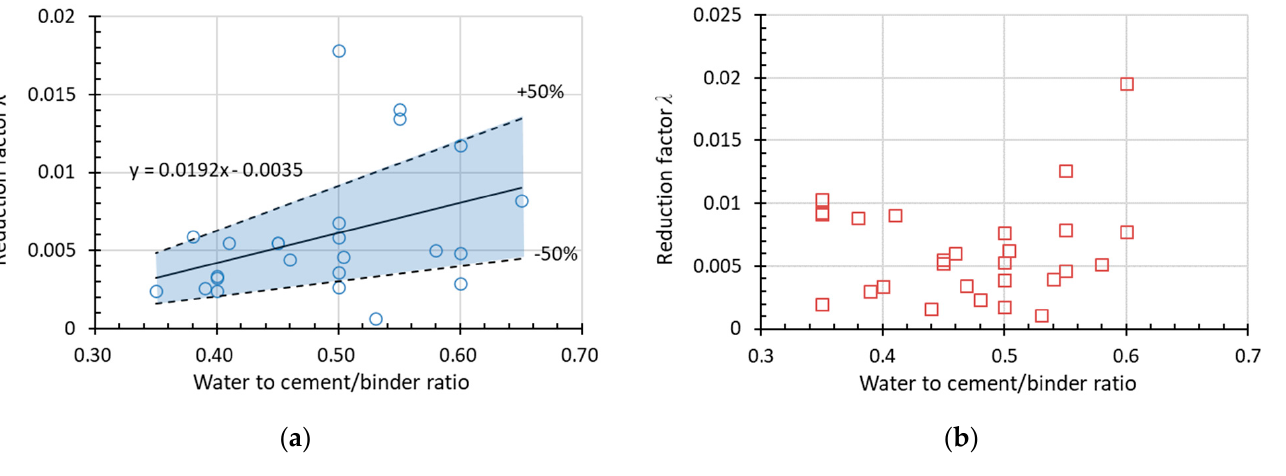
Figure 17. Factor λ in the linear function in terms of w/c for ( a ) RDEM and ( b ) Rf c of non-air-entrained concrete.